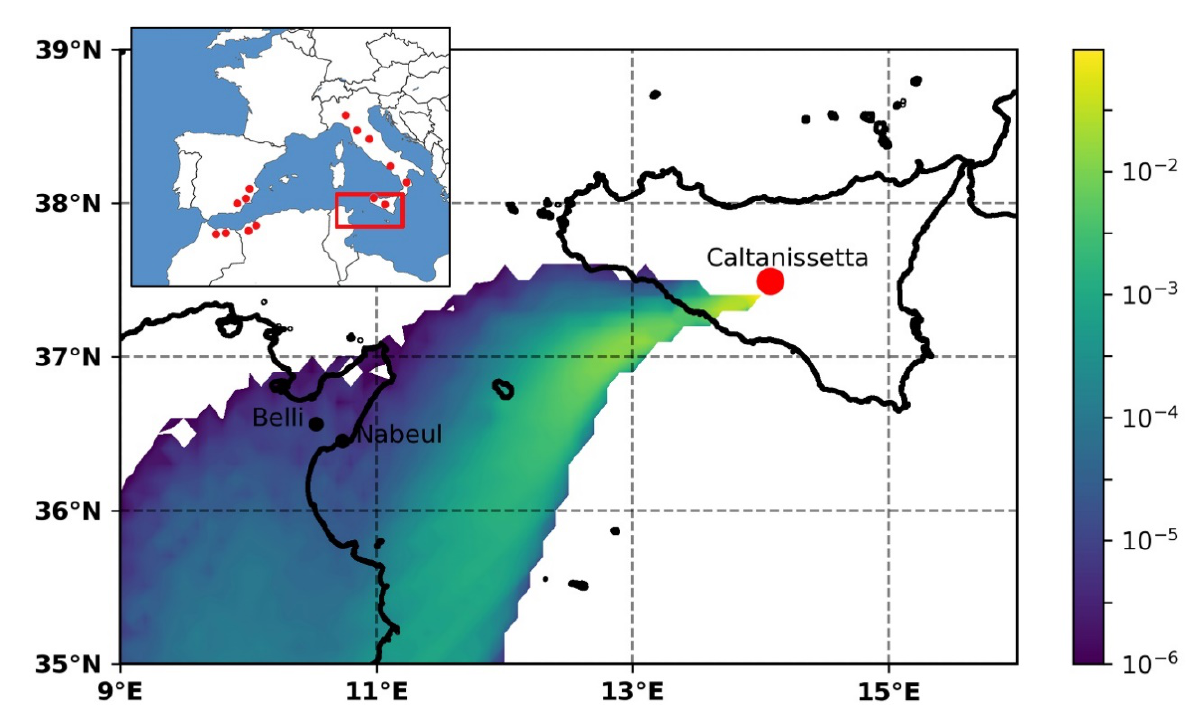
Figure 4. An episode of air mass possibly transporting microfossils from the emission area (Caltanissetta, Sicily) to the honey harvesting area shown on an atmospheric dispersion sensitivity map [m − 3 ] for the dust deflated between 18–6 UTC, 21–22 May 2011. Red dots in the small map show the distribution of Messinian diatomites.